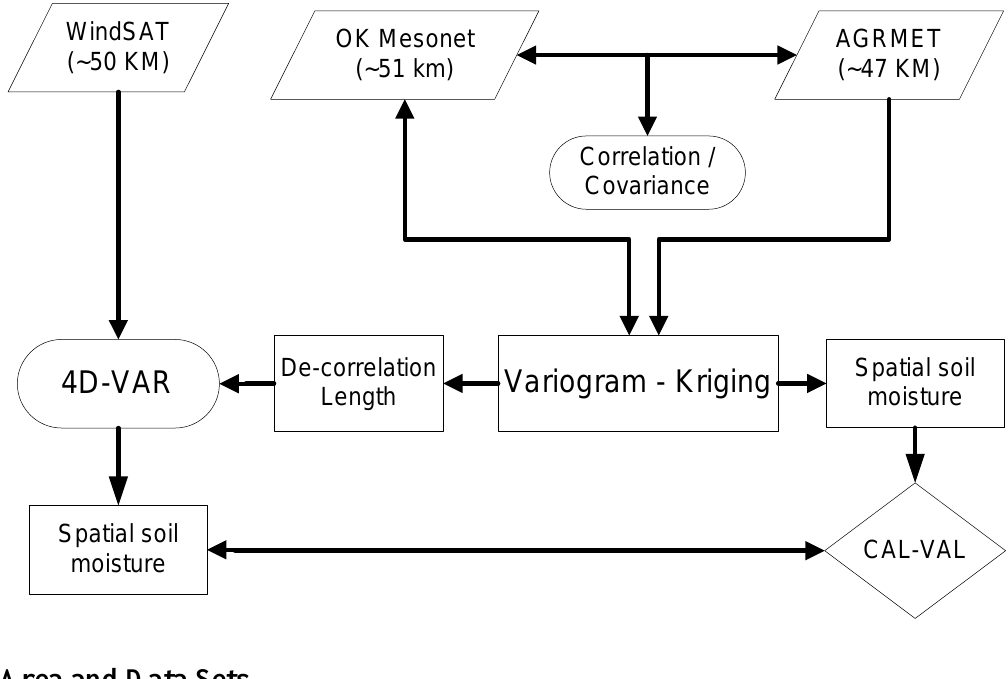
Figure 1. Application of variogram and kriging analysis in calibration and validation of soil moisture information for data assimilation